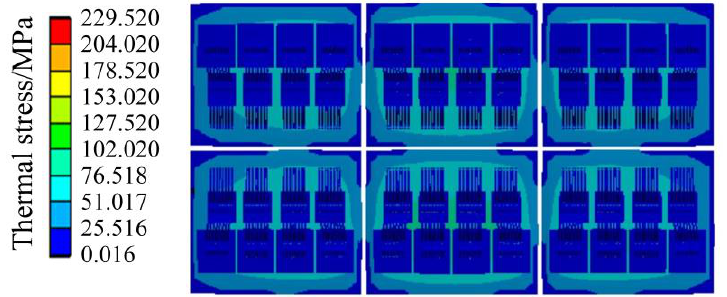
Figure 12. Thermal stress of the liner unit and above position.